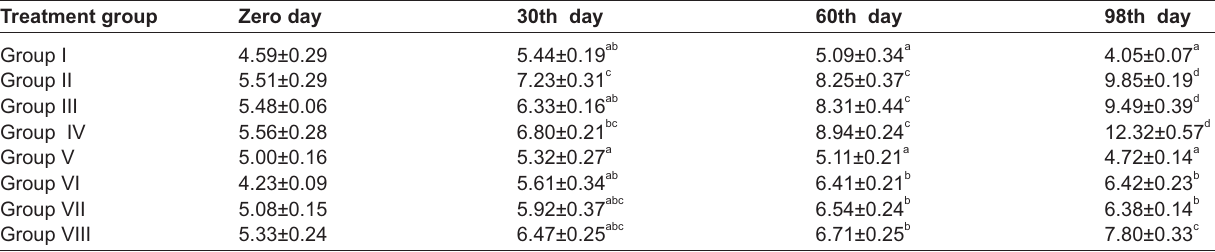
Table-1. Effect of repeated oral administration of chlorpyriphos, lead acetate, vitamin C alone, and in combinations on erythrocyte lipid peroxidation (n mole MDA formed/ml erythrocytes) in rats. Treatment group